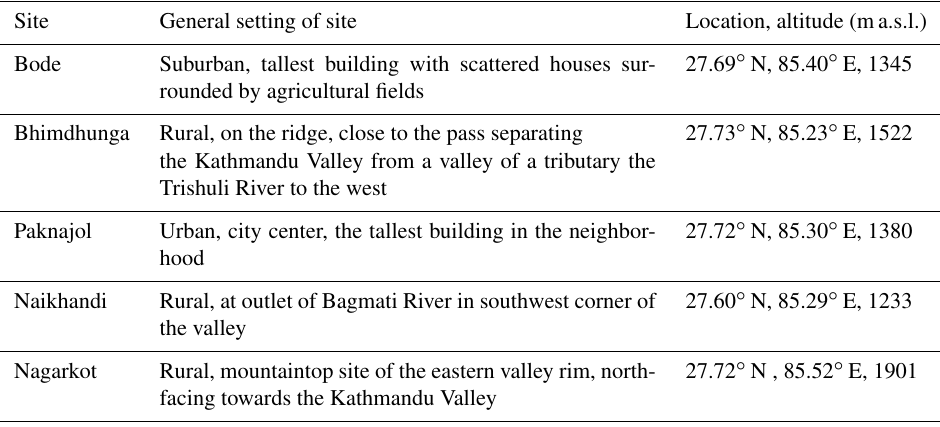
Table 1. Information on the sampling sites (of the SusKat-ABC campaign) used in this study. Sampling was carried out during 2013–2014 in the Kathmandu Valley. The altitude is in meters above mean sea level (ma.s.l.).